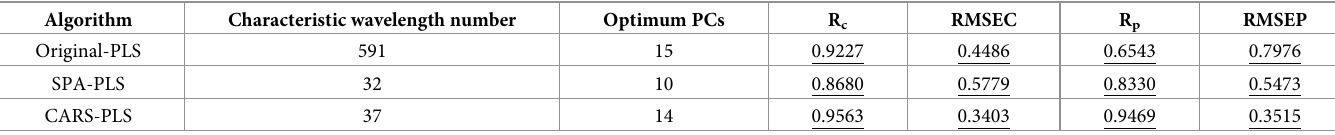
Table 5. Comparative analysis of PLS model